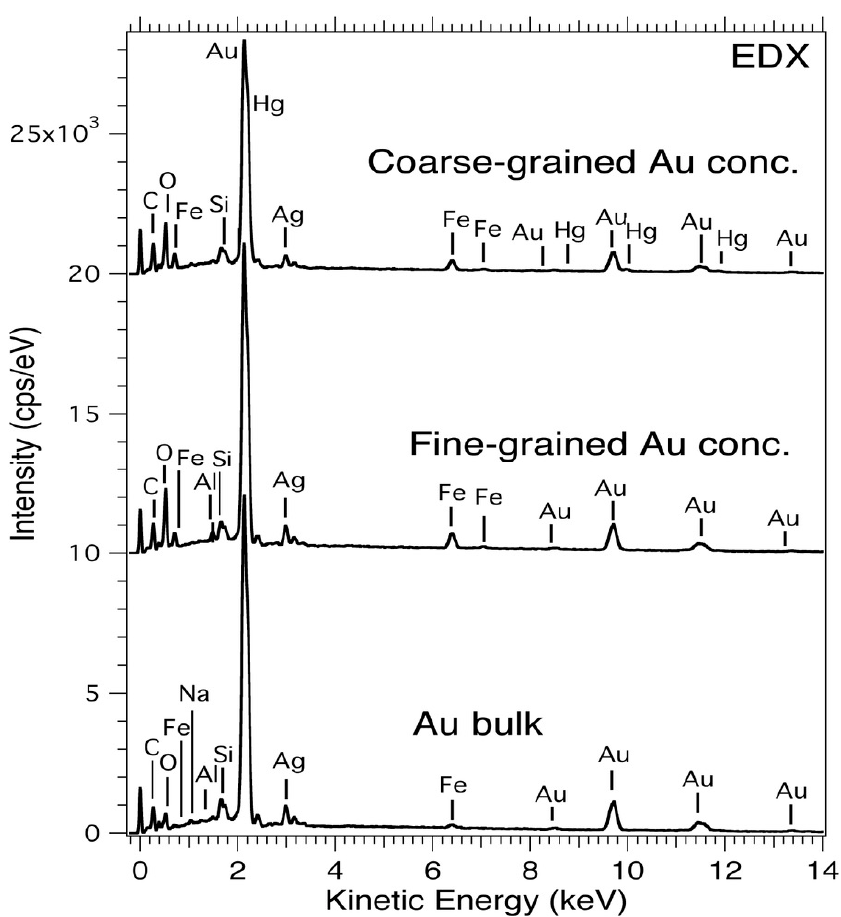
Figure 9. EDX spectra of bulk Au, fine-grained, and coarse-grained Au powder concentrate samples. Table 3. Elements identified in the EDX analysis of bulk Au and Au powder (fine-grained and coarse-grained) concentrate samples.